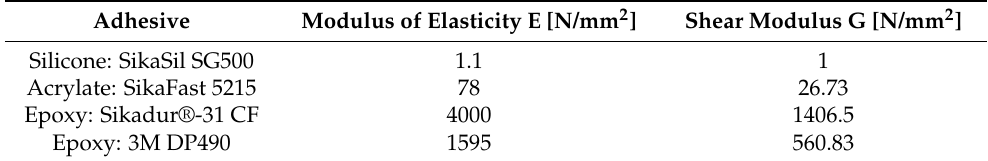
Table 5. Material properties of used adhesives.